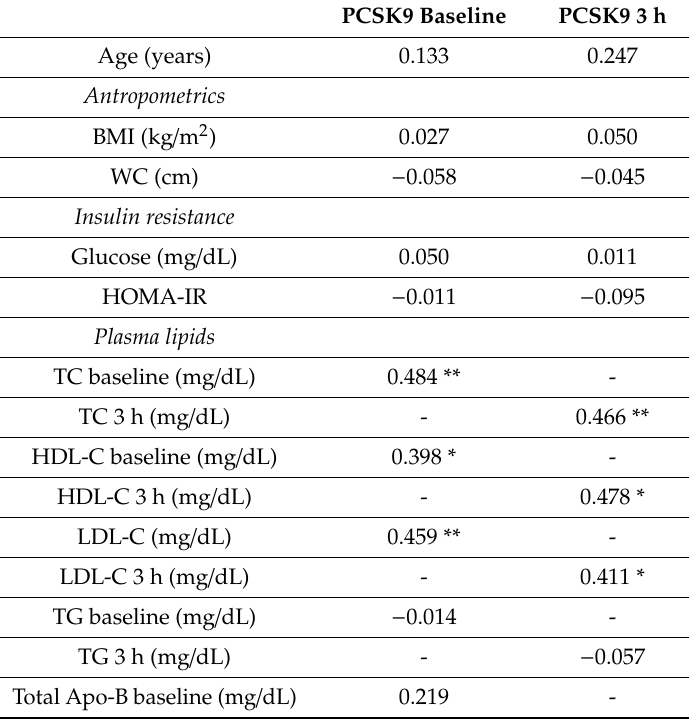
Correlation coe ffi cients among baseline and 3 h post fat load PCSK9, clinical and anthropometrical characteristics, lipid parameters, and intestinal